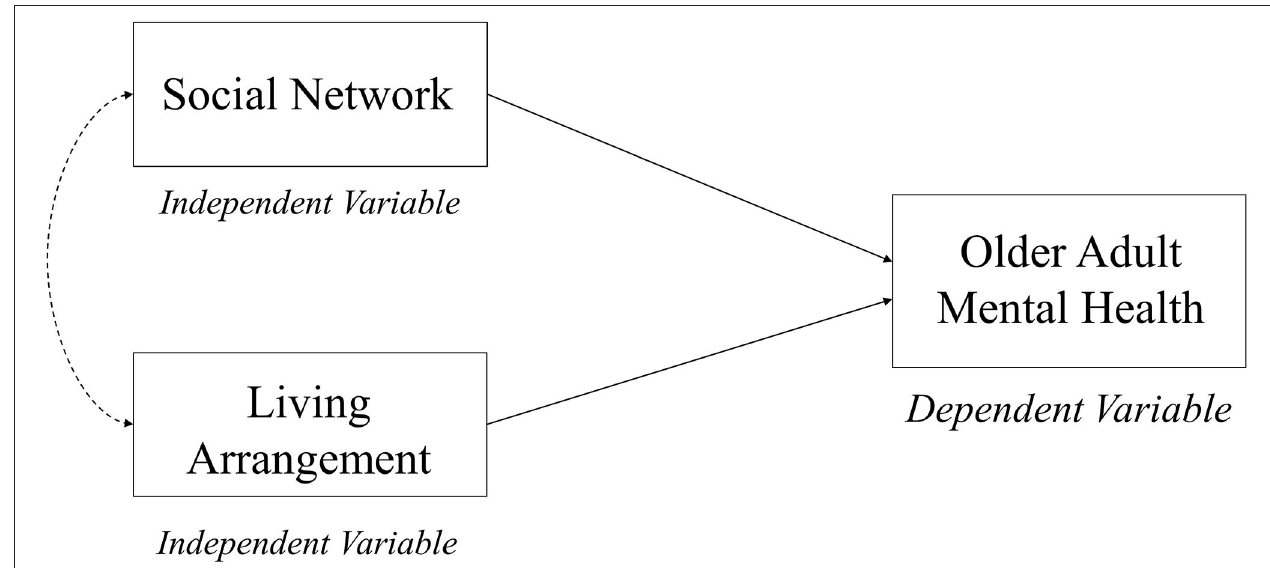
FIGURE 1 | The conceptual framework of the interaction